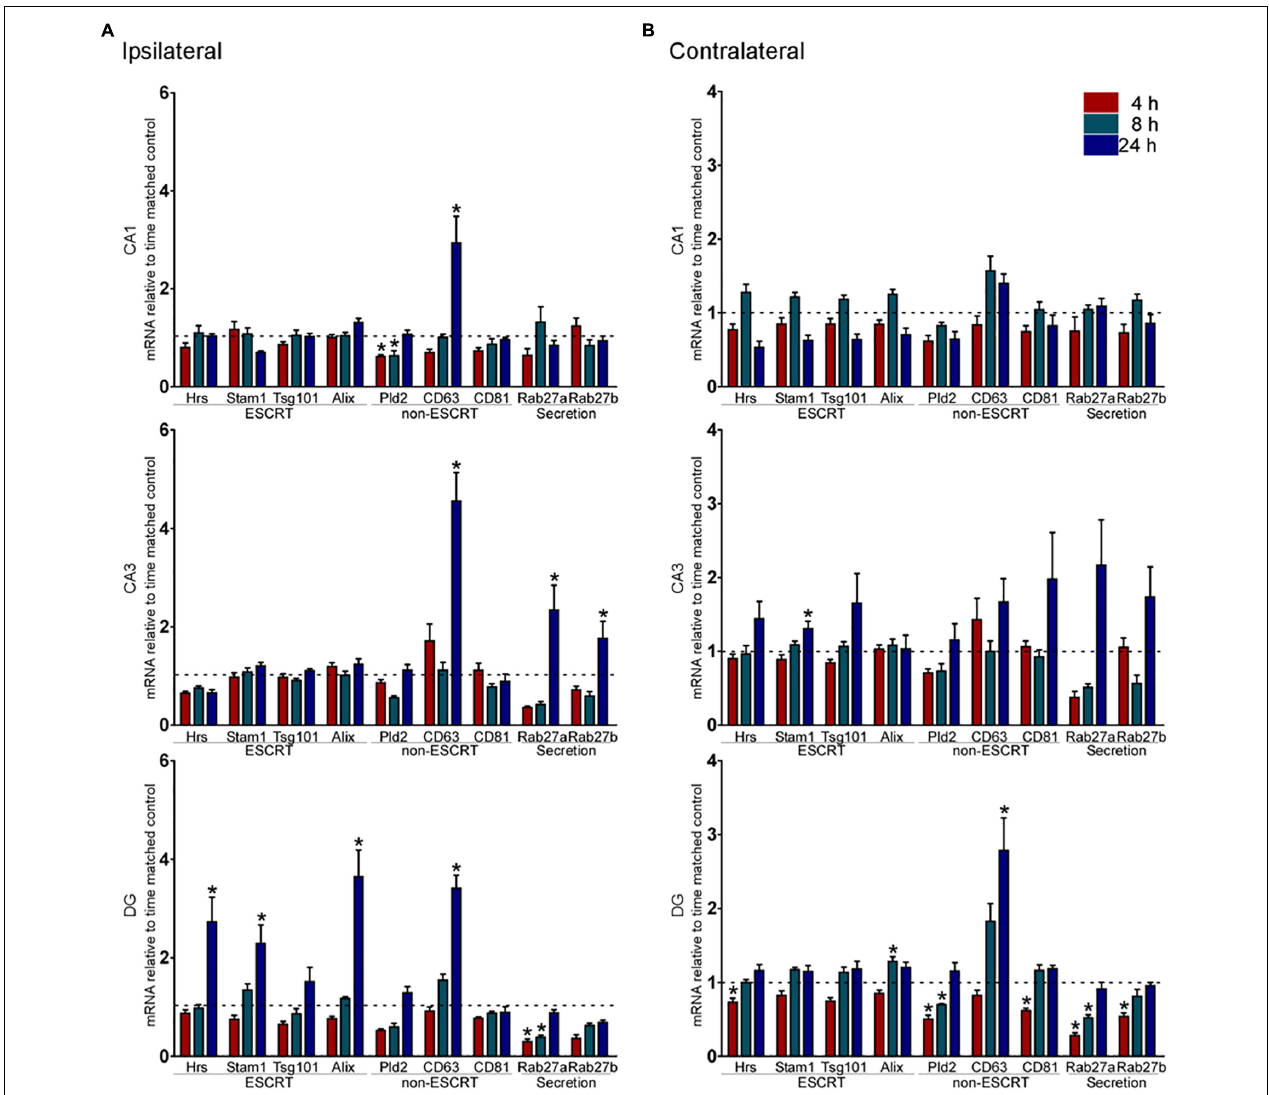
FIGURE 1 | Acute changes to exosome biogenesis transcripts after status epilepticus in hippocampal subfields. Graphs show transcript (mRNA) levels 4, 8, and 24 h after status epilepticus (SE) induced by KA compared to control in each subfield of the (A) ipsilateral and (B) contralateral, hippocampus. Levels were normalized to β -actin . Shown are ESCRT-dependent exosome biogenesis transcripts, ESCRT-independent exosome biogenesis transcripts, and potential exosome secretion transcripts. Dotted line indicates control level. Graphs show mean ± SEM. ∗ p < 0.05 compared to matching control. n = 4–6 per group; ANOVA with Bonferroni post hoc